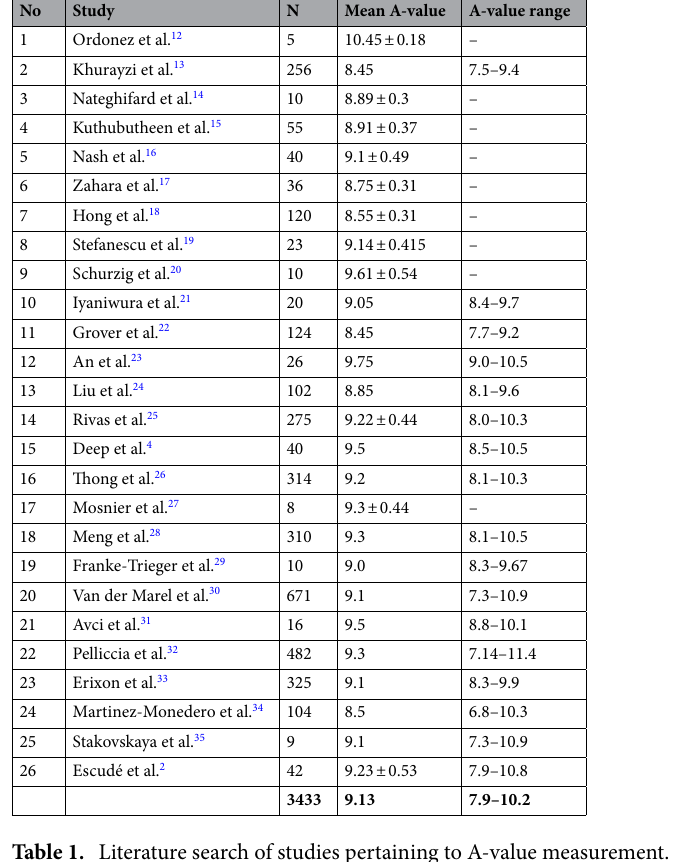
10.2 mm with an average value of 9.13 mm. None of the articles within the inclusion criteria reported on the A-value in malformed cochleae. Data analyses. Of the seventy-four cochleae investigated there were: 10 normal, 3 with EVA, 25 with CH, 15 with IP type I, 11 with IP type II, and 10 with IP type III. HRCT images with the A-value and C-value, and corresponding 3D segmented images covering all the anatomical types of the inner-ear in cochlear view are shown in Fig. 2a. Images of all the seventy-four cochlear samples used are provided in Fig. 2b. The A-values and the C-Values (mean ± standard deviation) for each group are shown in Fig. 3a,b, respectively. The A-values of the normal cochleae compared to the cochleae with CH ( p < 0.001), IP type I ( p = 0.049), IP type II ( p = 0.038), and IP type III ( p < 0.001) were significantly different. However, the A-values of the normal coch- leae were not significantly different to the cochleae with EVA ( p < 0.430). The C-values of the normal cochleae compared to the cochleae with IP type I ( p < 0.001) and IP type III ( p < 0.001) were significantly different, but there were no significant differences between the C-value and the other malformation types. The A-values of the normal cochleae were significantly different to the combined A-values of the cochleae with a malformation ( p < 0.001) (Fig. 4a). The C-values of the normal cochleae were not significantly different to the combined C-values of the cochleae with a malformation (Fig. 4b). Table 2 shows the exact A- and C-values (mean ± standard deviation) for the normal cochleae and each type of malformation, the p -values of the differences as determined by t -test between the A- and C-values, and the p -values of the regression analyses. The A-value of the normal cochleae (Fig. 5a), EVA (Fig. 5b), CH (Fig. 5c), IP type I (Fig. 5d), IP type II (Fig. 5e), or IP type III (Fig. 5f) were not significant predictors of the corresponding C-value. The proximity of the facial nerve to the cochlear basal turn of the cochlea at around 270° of angular depth, was evaluated subjectively in all 74 samples and it was determined that the proximity was highly variable, regardless of the anatomical type (Fig. 2b). Discussion The data collected shows that while the A-value measurement has been reported in the literature and is used to determine the CDL in clinical practice, the A-value measurement varies greatly. A-value measurements for CDL prediction apply only to normal cochleae as the mathematical equations to estimate CDL are derived taking